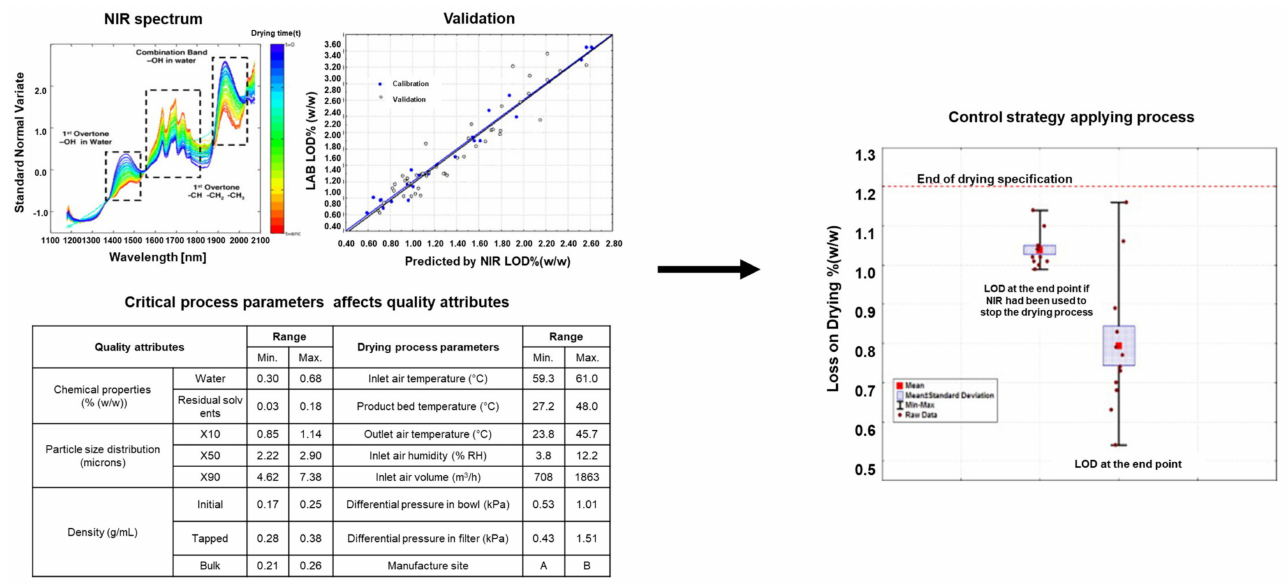
Figure 3. Positioning of a near-infrared (NIR) spectrometer in a fluidized-bed drying process and the steps of the process control strategy using PAT [248]. Reproduced with permission from Antonio Peinado, Journal of Pharmaceutical and Biomedical Analysis; published by Elsevier,